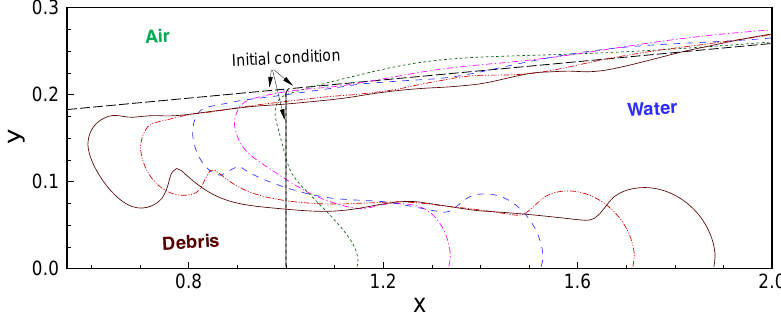
Figure 14. Profiles of debris and water ( φ 2 : water).